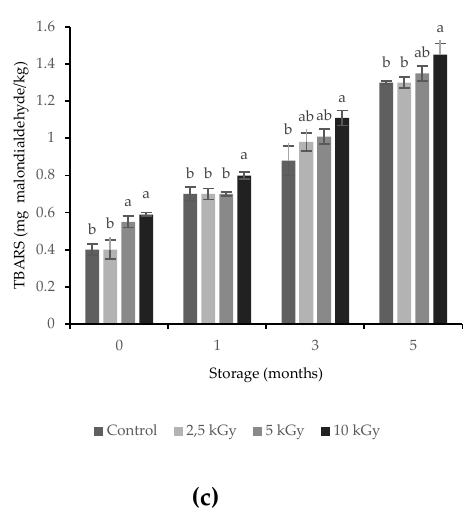
Figure 4. The antioxidant properties and changes of irradiated and control tarhana samples during storage. ( a ) 2,2-diphenyl-1-picrylhydrazyl (DPPH) radical scavenging activity, ( b ) total phenolic content (TPC), ( c ) thiobarbituric acid reactive substances (TBARS). Capital letters represent the p < 0.05 level of statistical di ff erence between the storage times of the tarhana samples, while the lower-case letters show the p < 0.05 level of statistical di ff erence between the irradiation doses.